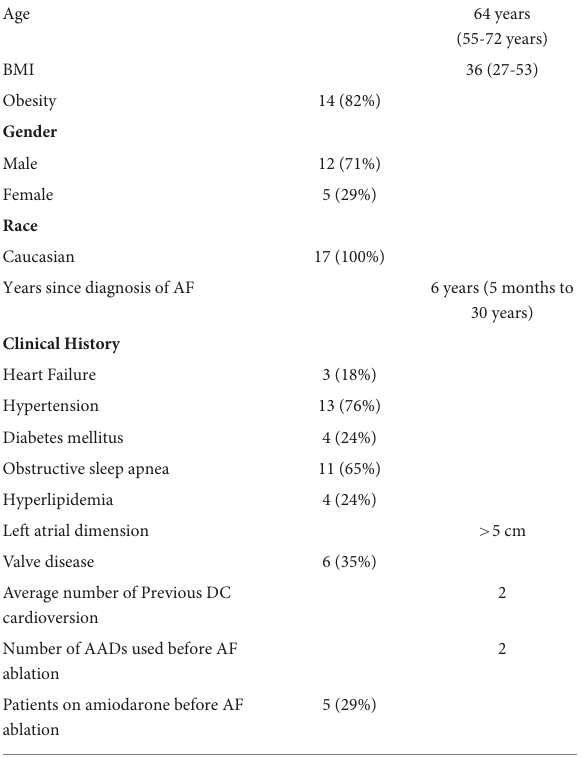
TABLE 1 Baseline clinical